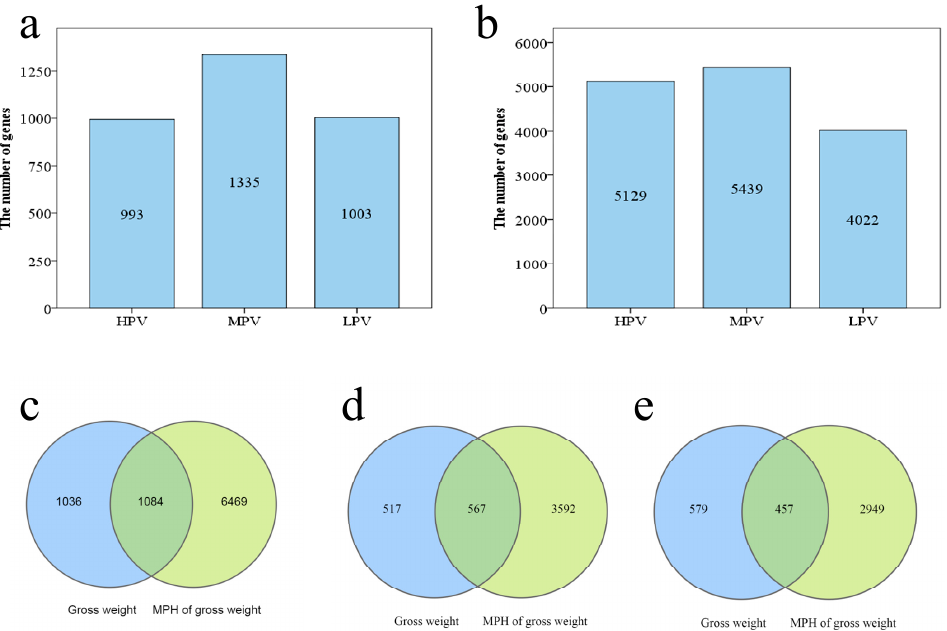
Figure 2. Number of genes correlated to observed value and mid-parent heterosis value of plant growth weight. ( a ) Number of genes correlated to plant growth weight. ( b ) Number of genes correlated to mid-parent heterosis value of plant growth weight. ( c ) Number of genes correlated to observed value and mid-parent heterosis value of plant growth weight. ( d ) Number of genes positively correlated to observed value and mid-parent heterosis value of plant growth weight. ( e ) Number of genes negatively correlated to observed value and mid-parent heterosis value of plant growth weight. HPV: high-parent expression. MPV: mid-parent expression. LPV: low-parent expression.